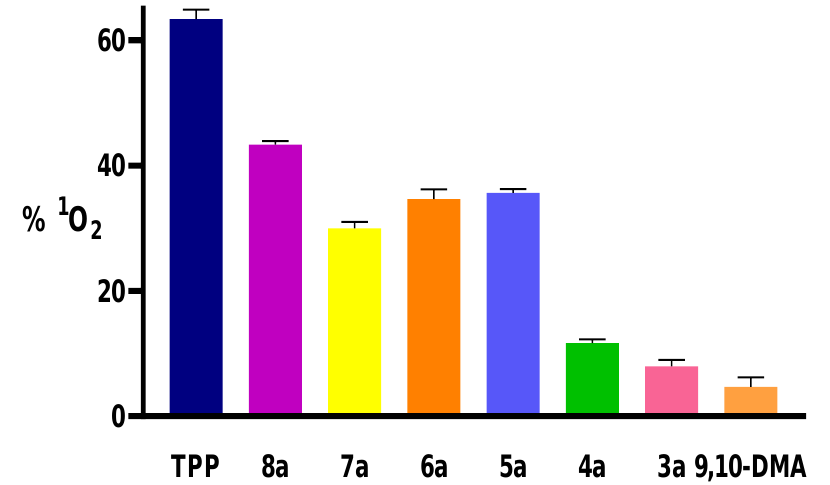
Figure 2. % 1 O 2 generation by Por – CD dyes 3a – 8a in DMF at 298 K.